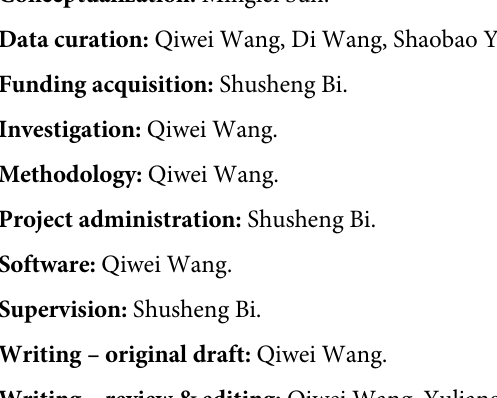
YOLOv3_320 × 320 detection models. We show detection results below with the highest